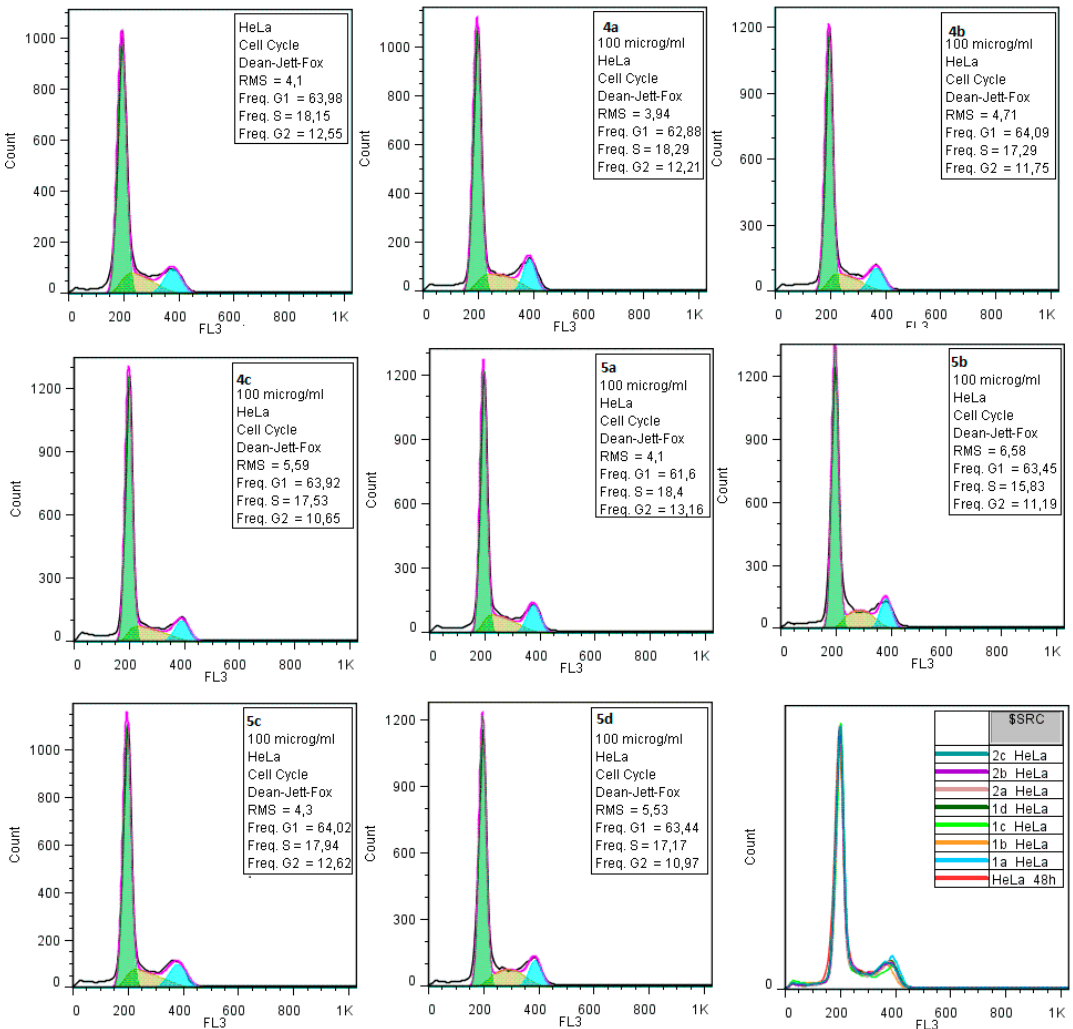
Figure 5. Flow cytometry histograms showing the influence of compounds 4a – c , 5a – d on the cellular cycle of HeLa and HaCaT cells. Y axis—intensity of fluorescence; X axis—the relative number of cells (15,000 events were investigated).